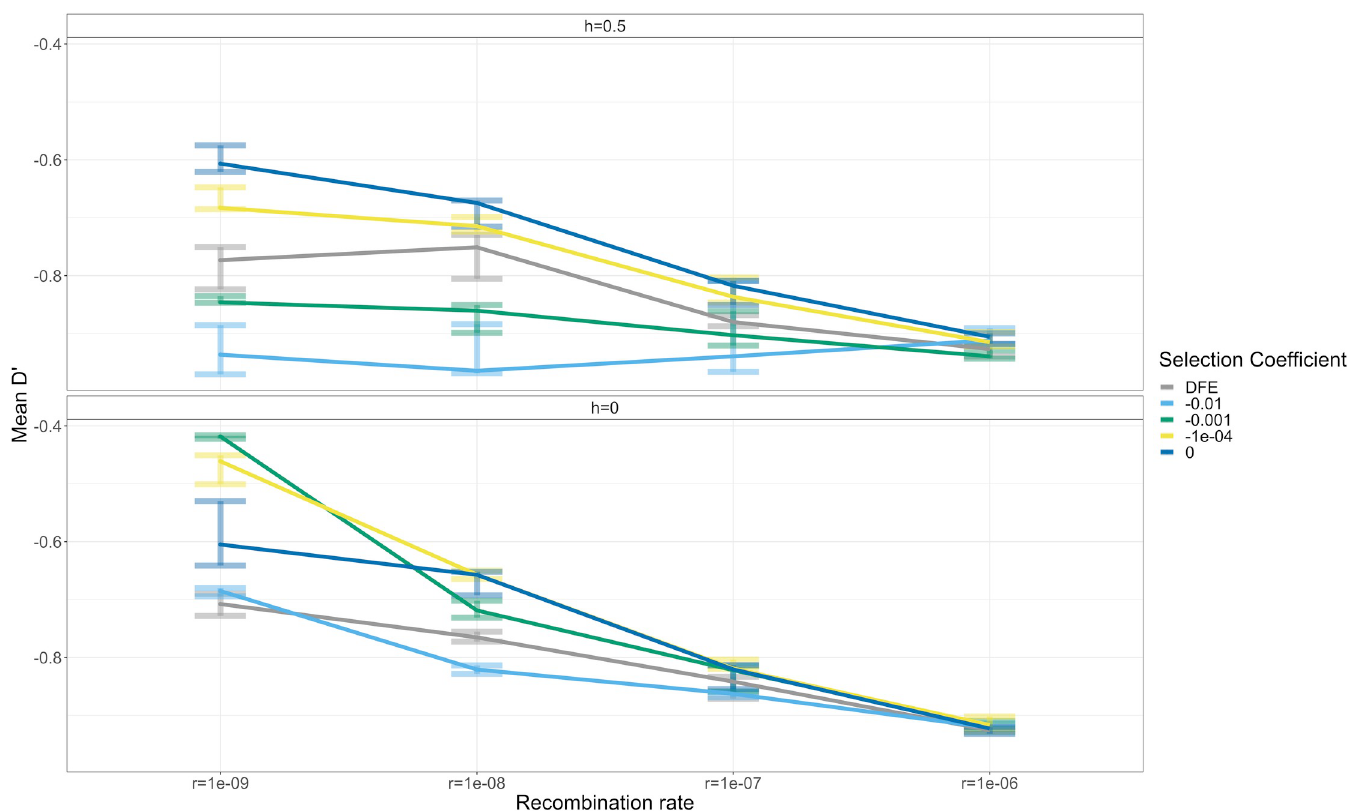
Fig 1. Mean D’ for simulated NS doubletons within 10kb from each other across different recombination and dominance parameters. The differences in the decay curves are most apparent for recombination rate r = 1 x 10 − 9 per bp and depend on the dominance coefficient of mutations ( h ) and the selection coefficient ( s ) of NS mutations. 150 simulation replicates were simulated for each scenario and were split into 3 groups consisting of 50 simulations. For each group, the mean value of D ’ is shown as the line and the error bars denote the minimum and maximum mean D ’ values.